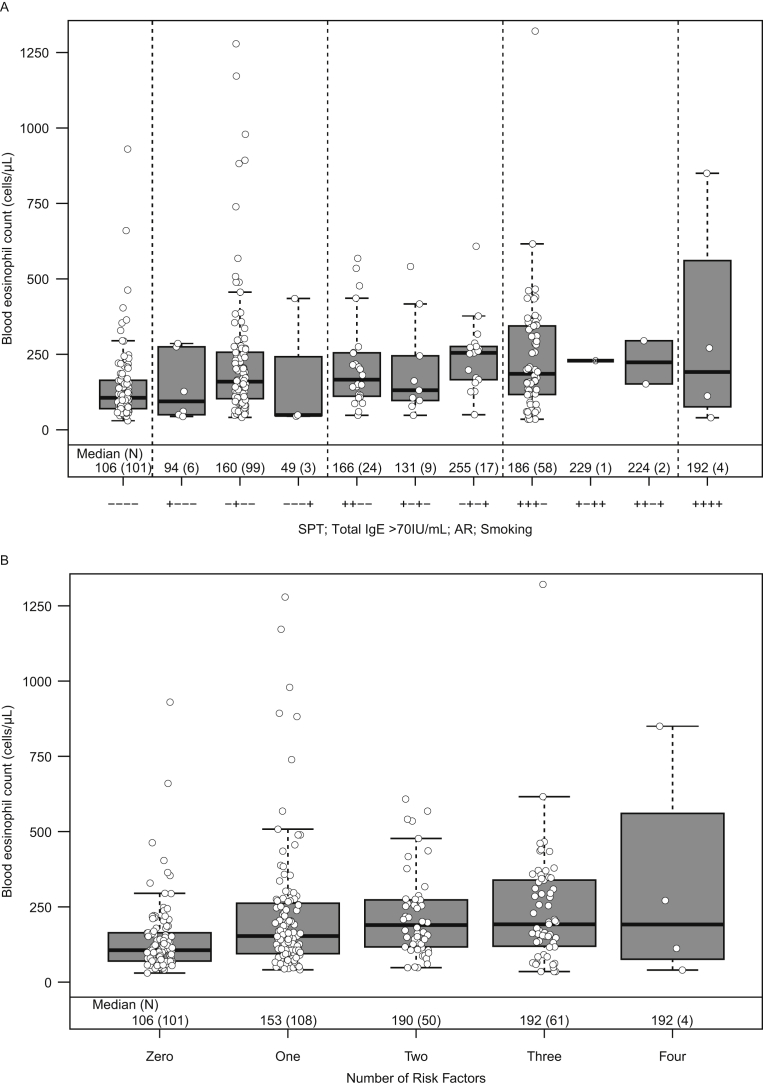
Stratified analysis of the effect of risk factor combinations on blood eosinophil count in non-asthmatic participants stratified by risk factor (A), and by cumulative number of risk factors (B). N = 324; all participants positive for helminth infection (n = 13) or with a missing data point for one or more stratifying factors (n = 81) were excluded from the stratified analysis; black bars represent median values and boxes represent IQR. AR, allergic rhinitis; IgE, immunoglobulin E; IQR, interquartile range; SPT, skin prick test